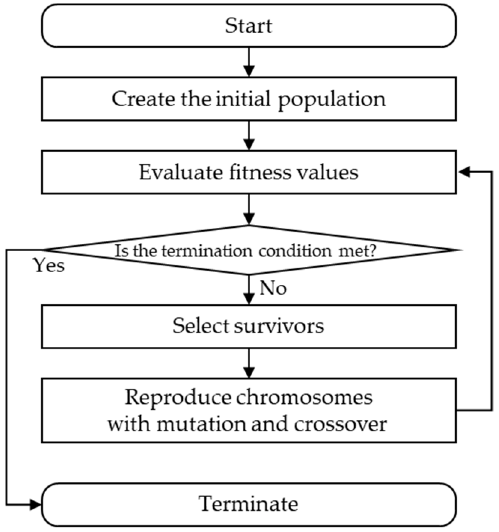
Figure 2. Overall framework of DIMPLED.